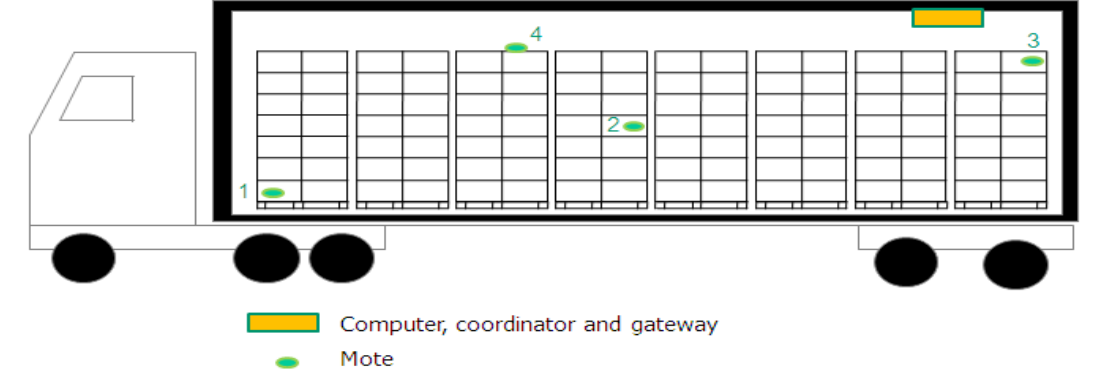
Figure 2. Proposal of WSN inside refrigerated trucks